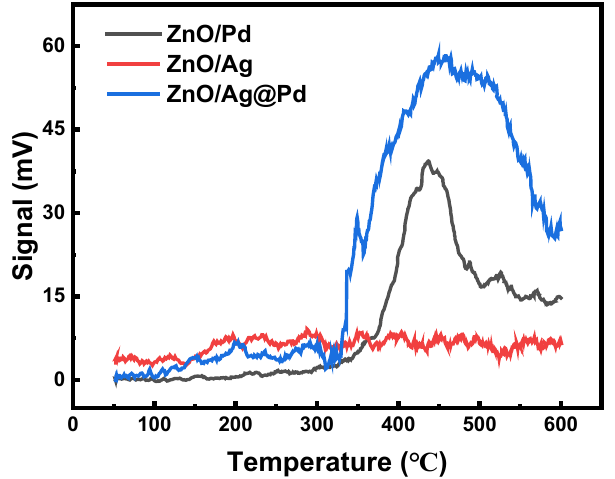
Figure 7. CO-TPD analysis of the ZnO/Pd, ZnO/Ag and ZnO/Ag@Pd.